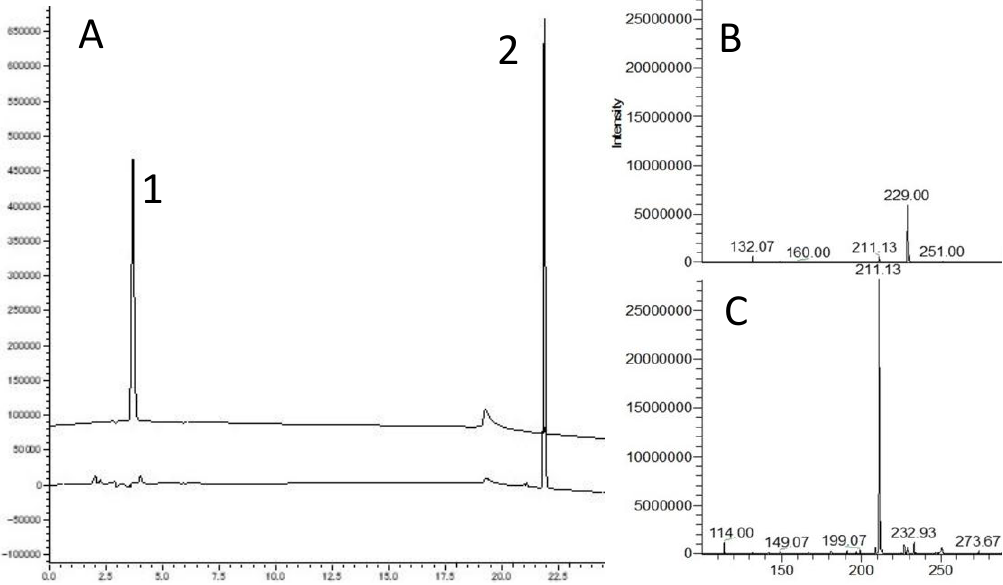
Figure 1. High-performance liquid chromatography (HPLC) and electrospray ionization mass spectrometry (ESI-MS) of linear and cyclic prolyl-hydroxyproline (Pro-Hyp). ( A ) The HPLC chromatogram peaks of (1) the linear Pro-Hyp and (2) after heating at 50 °C in 0.02 M ammonia solution. ( B ) Electrospray ionization mass spectra of peaks 1 and ( C ) 2 recovered from HPLC.